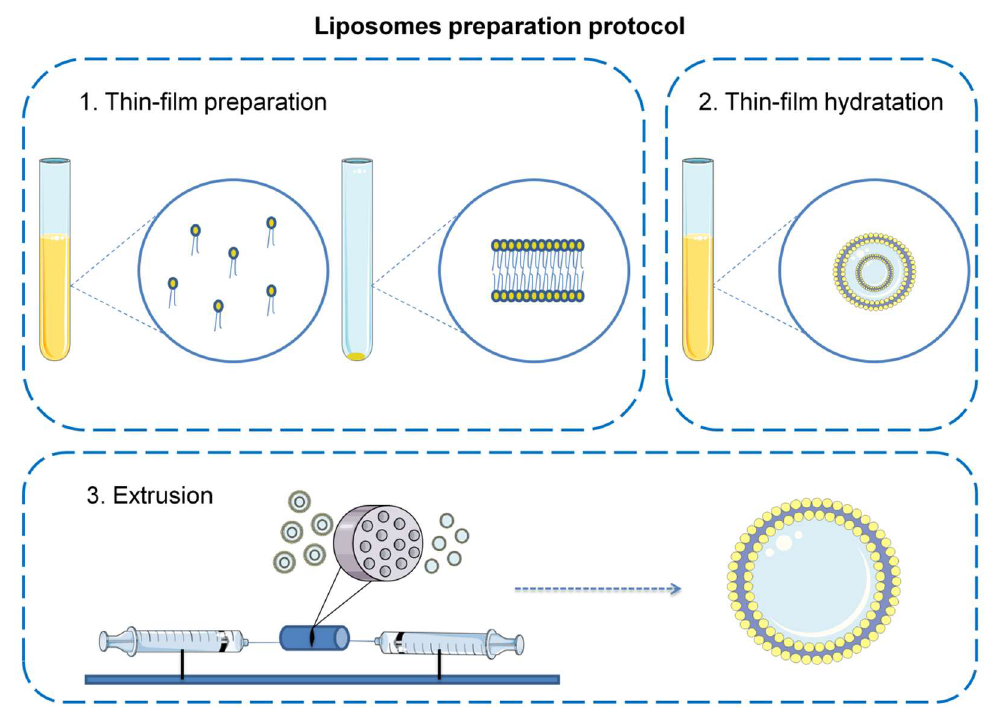
Figure 3. Schematic representation of liposomes preparation protocol.